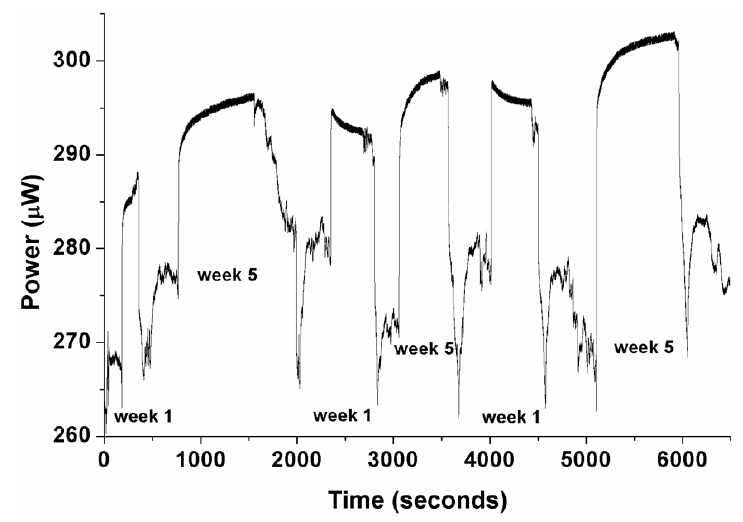
Figure 9. Measured response of polymer optical fiber sensor in two different samples of coolant fluid Castrol Syntilo 81BF with two different aging degrees (Week 1 and Week 5), after successive measurements. The inconsistency of the sensor’s behavior in real coolants, due probably to its deterioration in response to attack by the coolant’s specific components is clearly demonstrated.